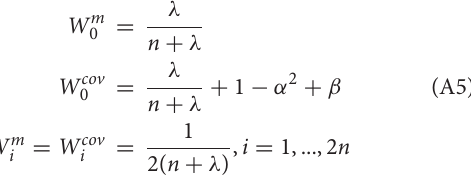
TABLE A1 | Variables of the Unscented Kalman Filter. Parameter